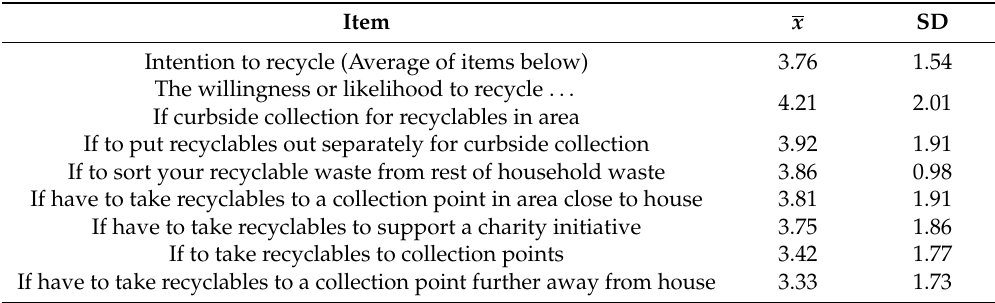
Table 3. Descriptive statistics for the intention of respondents to